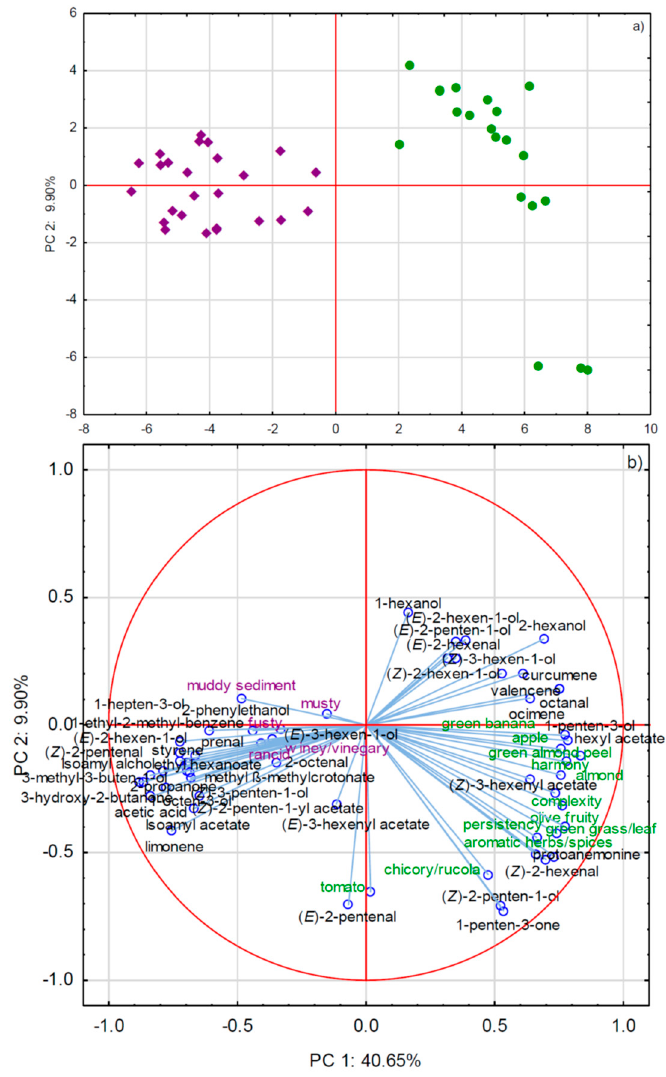
Figure 3. ( a ) Separation of olive oils sold as extra virgin olive oil (EVOO) in Italy according to